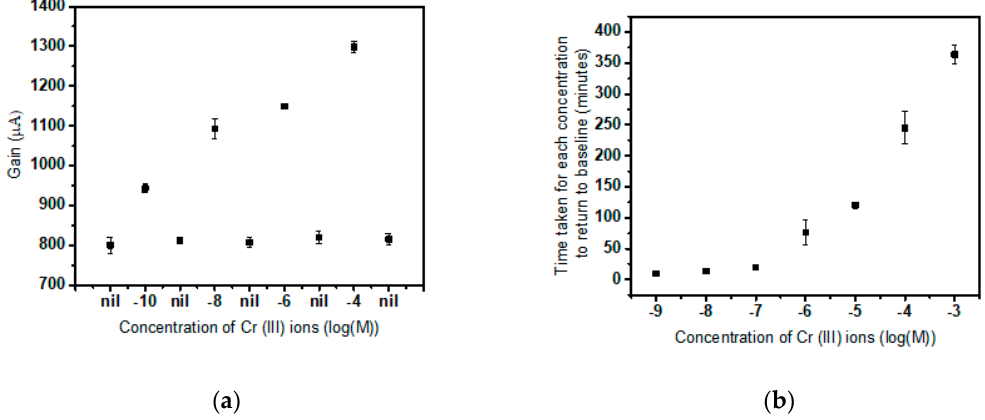
Figure 3. ( a ) The fundamental change in gain and successive return to baseline of the gain values when a stabilized sensor is exposed to consecutive concentrations of the target ion and alternatively eluted by buffer; ( b ) The time taken for different concentrations of target to accomplish